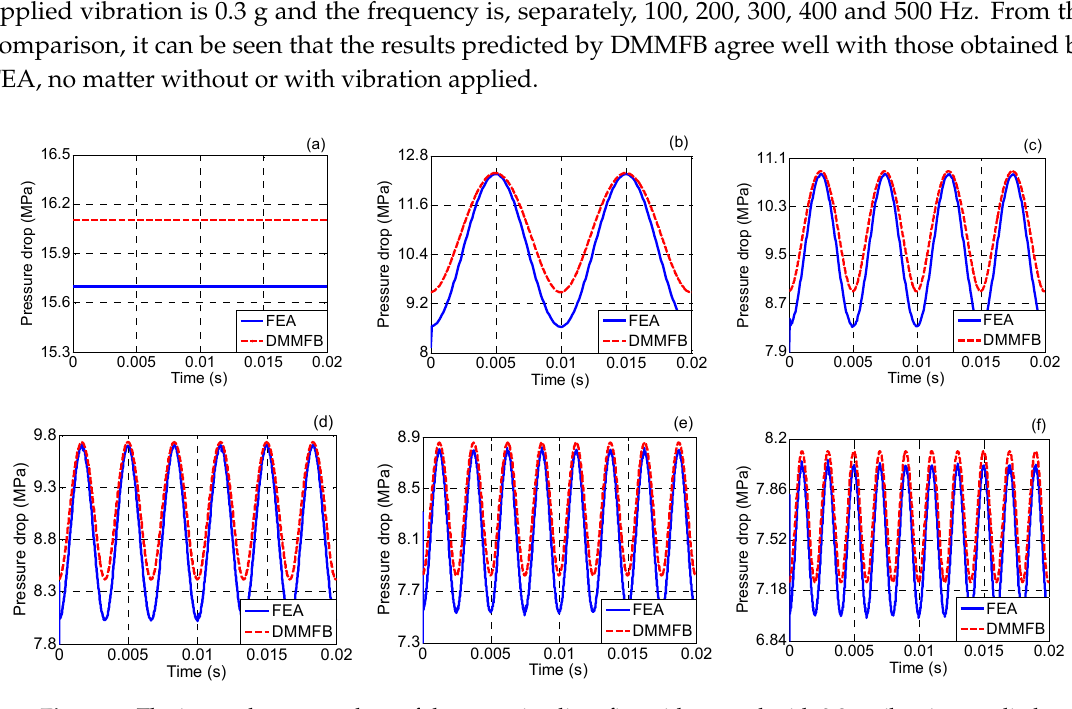
Table 4. Effective value of the pressure drop without and with 0.3 g vibration applied at different frequencies.